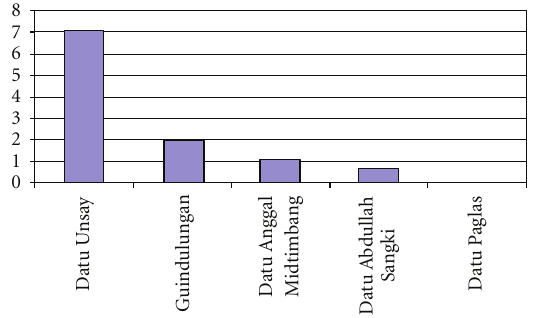
Figure 2: Prevalence of schistosomiasis in Maguindanao by munic- ipalities, 2008.